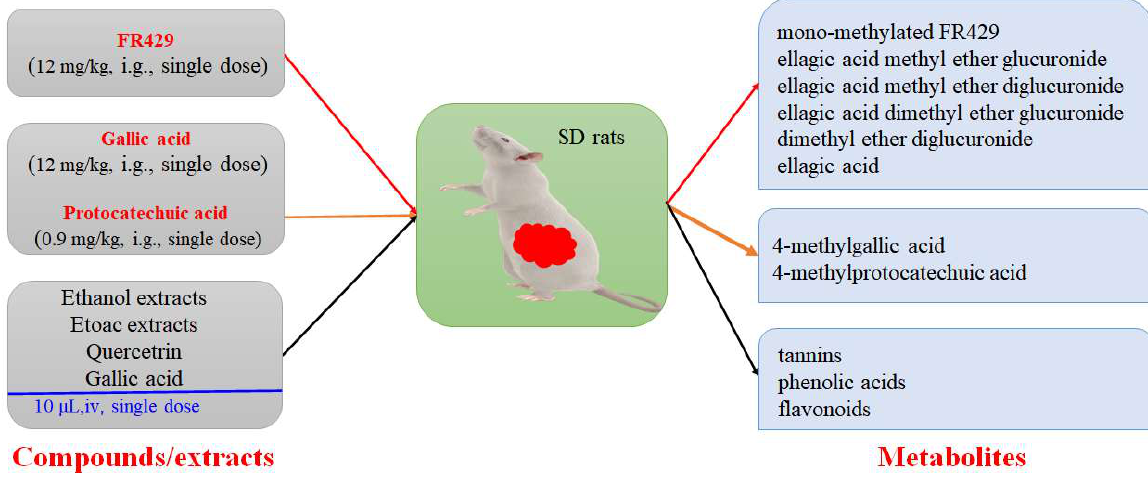
Figure 5. The pharmacokinetic and metabolite analysis of compounds from P. capitatum .